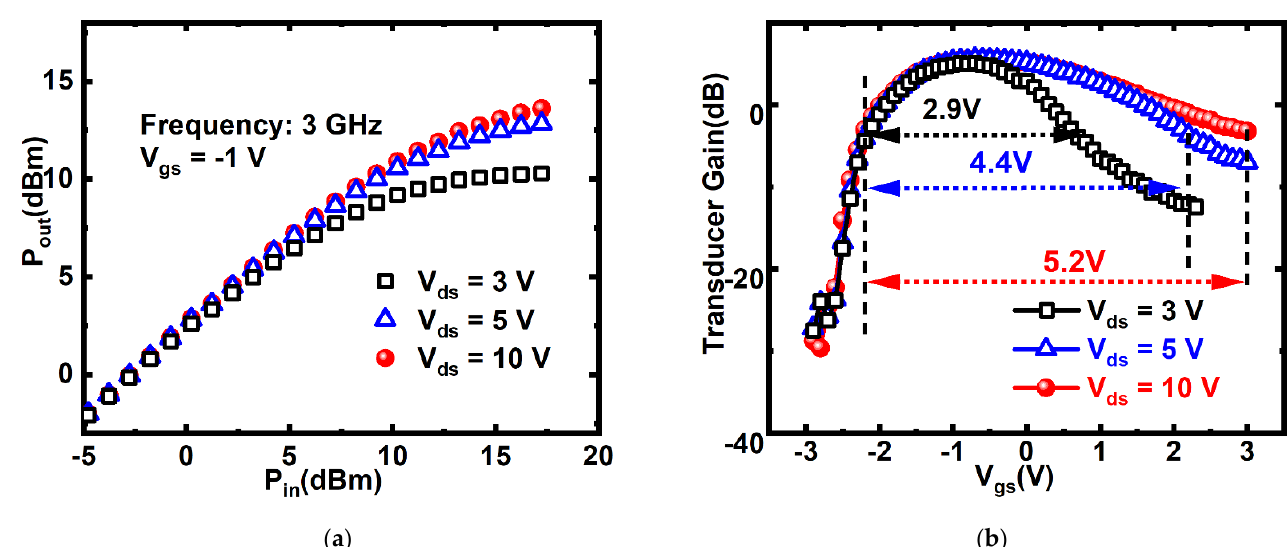
Figure 4. ( a ) P out versus P in at different V ds ; ( b ) transducer gain in small signal mode versus V gs .